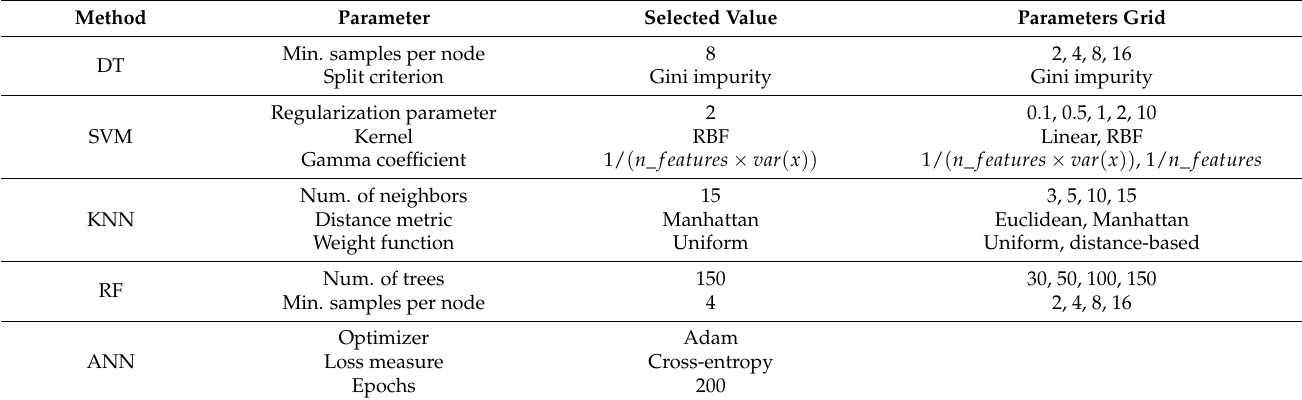
Table 3. Configuration setting per classification method. It was adjusted from FS1.